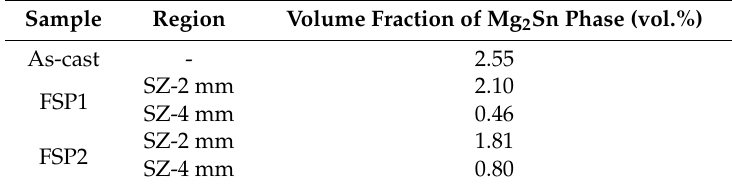
Figure 4. BSE-SEM images of the SZ-2 mm and SZ-4 mm regions of Mg-6Sn samples from FSP: ( a ) SZ-2 mm region of FSP1 sample, ( b ) SZ-2 mm region of FSP2 sample, ( c ) SZ-4 mm region of FSP1 sample, and ( d ) SZ-4 mm region of FSP2 sample. Table 1. Volume fraction of Mg 2 Sn phase in the SZ-2 mm and SZ-4 mm regions of Mg-6Sn samples from FSP. Sample